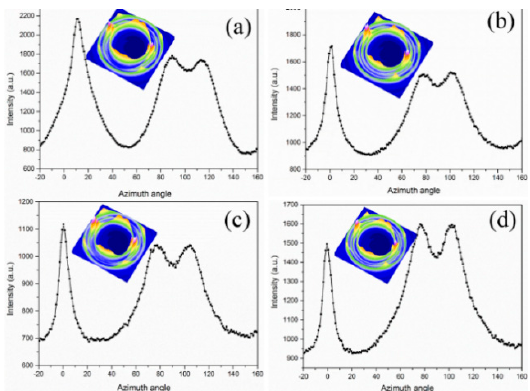
Figure 11. The azimuthal spreads of the (110) plane in different M-parts: ( a , c ): PPET0; ( b , d ): PPET10; ( a , b ): T mold = 80 °C. ( c , d ): T mold = 120 °C.